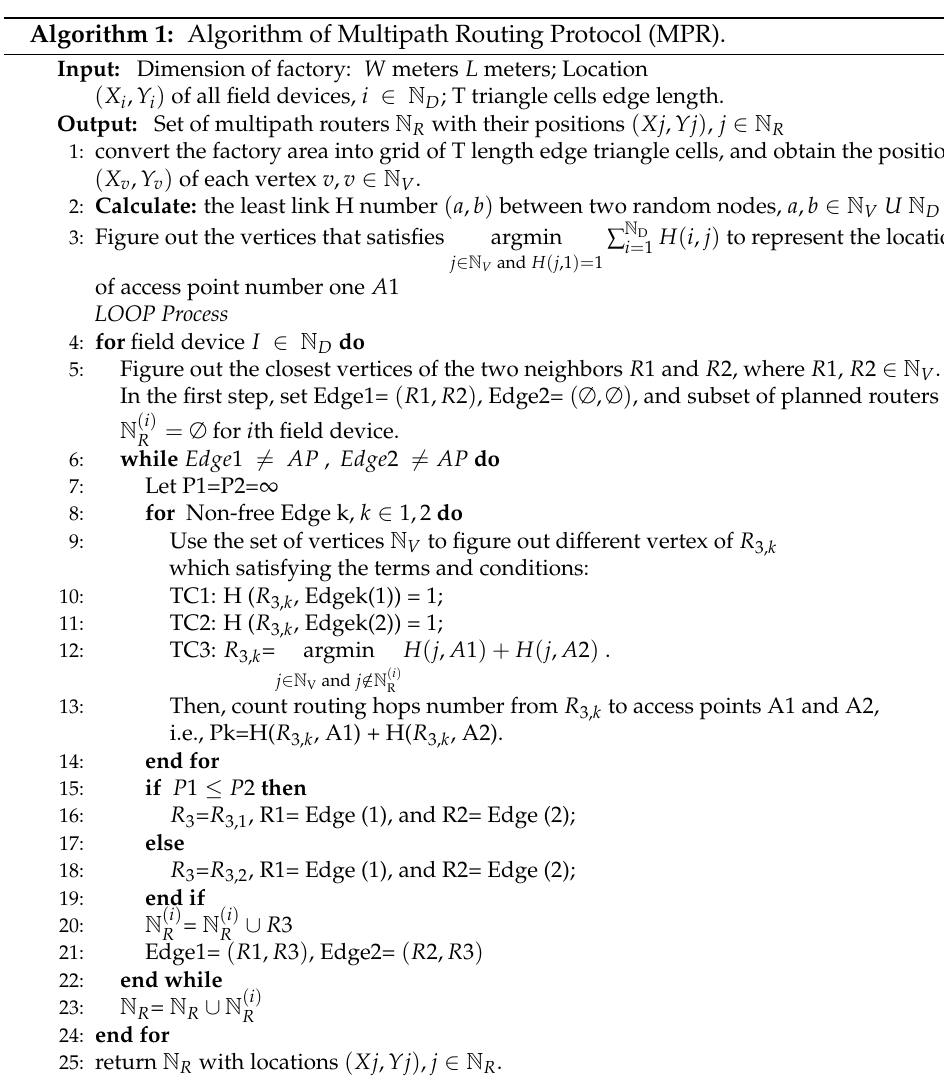
Algorithm 1: Algorithm of Multipath Routing Protocol (MPR).